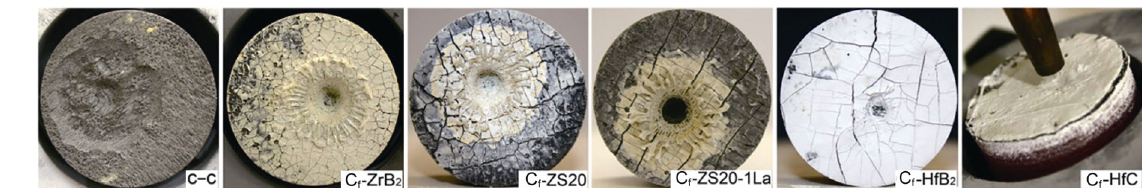
Fig. 28 Optical images of C/C and C f /UHTCs composites after 60-s oxyacetylene torch test. Reproduced with permission from Ref. [288], © Elsevier Ltd. 2013.